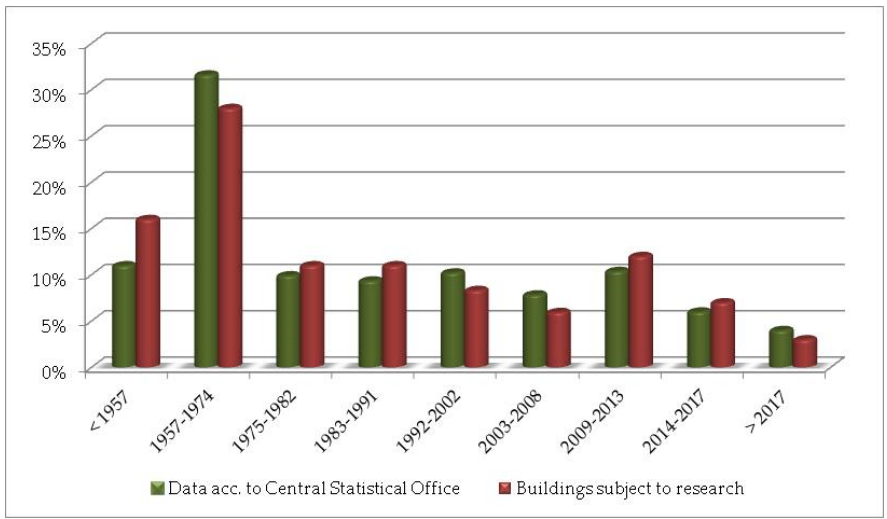
Figure 2. Age structure of single-family residential buildings in the Krakow area.